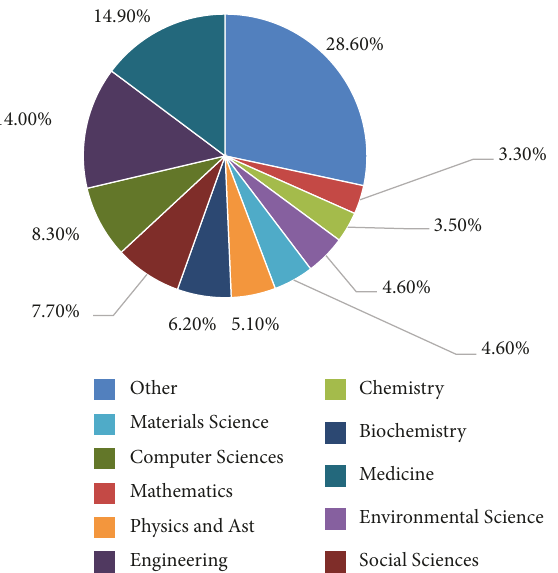
Figure 29: Pie chart depicting article distribution by disciplines for mixed-methods review